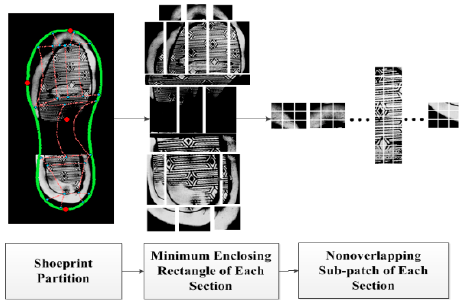
Figure 6. Illustration of the partial layer feature extraction method.